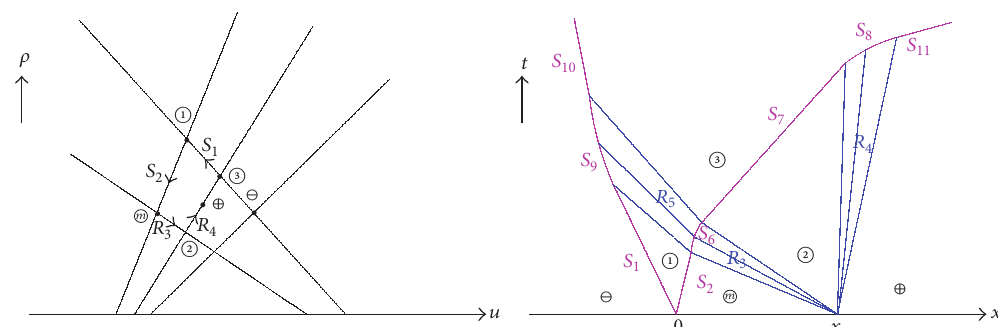
Figure 7: The interaction between 𝑆 + 𝑆 and 𝑅 + 𝑅 is shown when (𝑢 + ,𝜌 + ) ∈ 𝑉 6